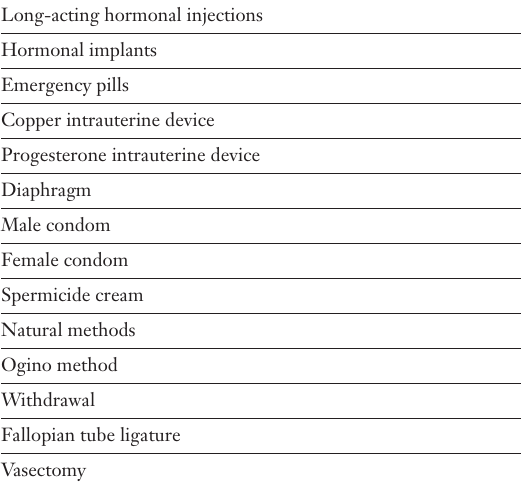
Table 1 List of contraceptive methods proposed in the 2 nd part of the